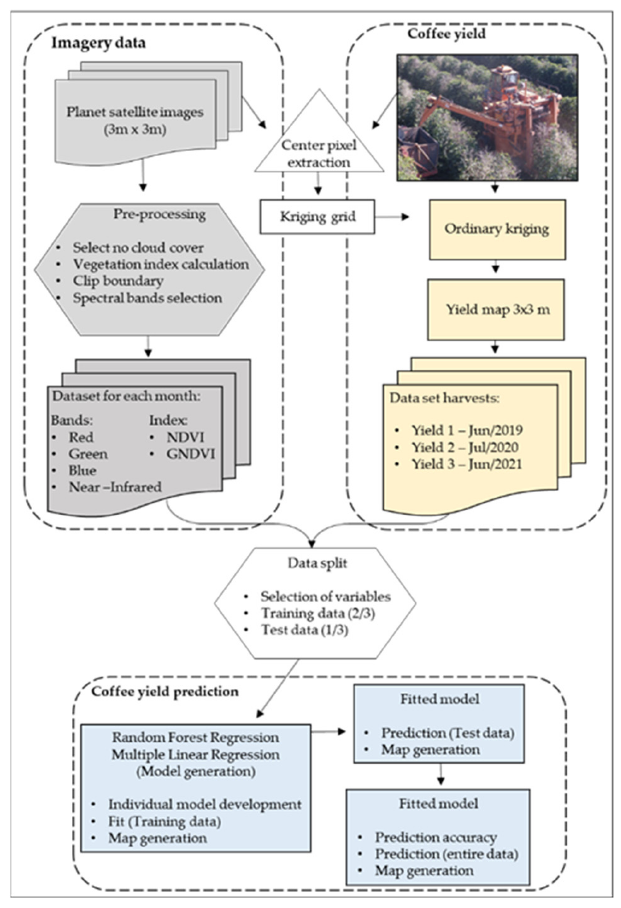
Figure 2. Coffee-yield prediction and mapping flowchart.